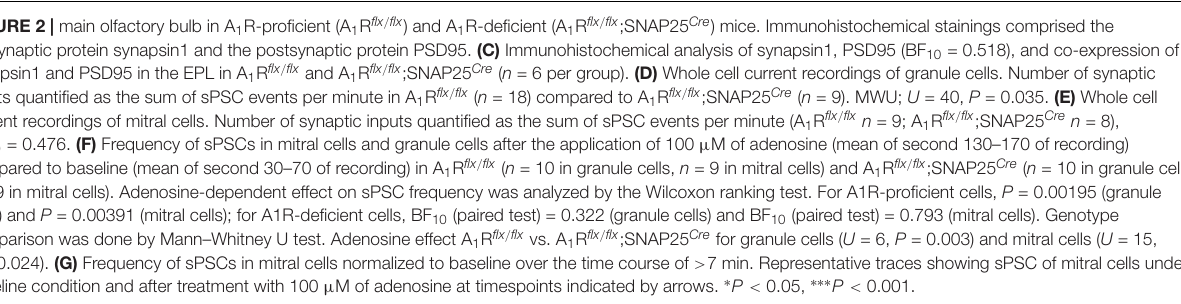
FIGURE 2 | main olfactory bulb in A 1 R-proficient (A 1 R flx / flx ) and A 1 R-deficient (A 1 R flx / flx ;SNAP25 Cre ) mice. Immunohistochemical stainings comprised the presynaptic protein synapsin1 and the postsynaptic protein PSD95. (C) Immunohistochemical analysis of synapsin1, PSD95 (BF 10 = 0.518), and co-expression of synapsin1 and PSD95 in the EPL in A 1 R flx / flx and A 1 R flx / flx ;SNAP25 Cre ( n = 6 per group). (D) Whole cell current recordings of granule cells. Number of synaptic inputs quantified as the sum of sPSC events per minute in A 1 R flx / flx ( n = 18) compared to A 1 R flx / flx ;SNAP25 Cre ( n = 9). MWU; U = 40, P = 0.035. (E) Whole cell current recordings of mitral cells. Number of synaptic inputs quantified as the sum of sPSC events per minute (A 1 R flx / flx n = 9; A 1 R flx / flx ;SNAP25 Cre n = 8), BF 10 = 0.476. (F) Frequency of sPSCs in mitral cells and granule cells after the application of 100 µ M of adenosine (mean of second 130–170 of recording) compared to baseline (mean of second 30–70 of recording) in A 1 R flx / flx ( n = 10 in granule cells, n = 9 in mitral cells) and A 1 R flx / flx ;SNAP25 Cre ( n = 10 in granule cells, n = 9 in mitral cells). Adenosine-dependent effect on sPSC frequency was analyzed by the Wilcoxon ranking test. For A1R-proficient cells, P = 0.00195 (granule cells) and P = 0.00391 (mitral cells); for A1R-deficient cells, BF 10 (paired test) = 0.322 (granule cells) and BF 10 (paired test) = 0.793 (mitral cells). Genotype comparison was done by Mann–Whitney U test. Adenosine effect A 1 R flx / flx vs. A 1 R flx / flx ;SNAP25 Cre for granule cells ( U = 6, P = 0.003) and mitral cells ( U = 15, P = 0.024). (G) Frequency of sPSCs in mitral cells normalized to baseline over the time course of > 7 min. Representative traces showing sPSC of mitral cells under baseline condition and after treatment with 100 µ M of adenosine at timespoints indicated by arrows. ∗ P < 0.05, ∗∗∗ P <